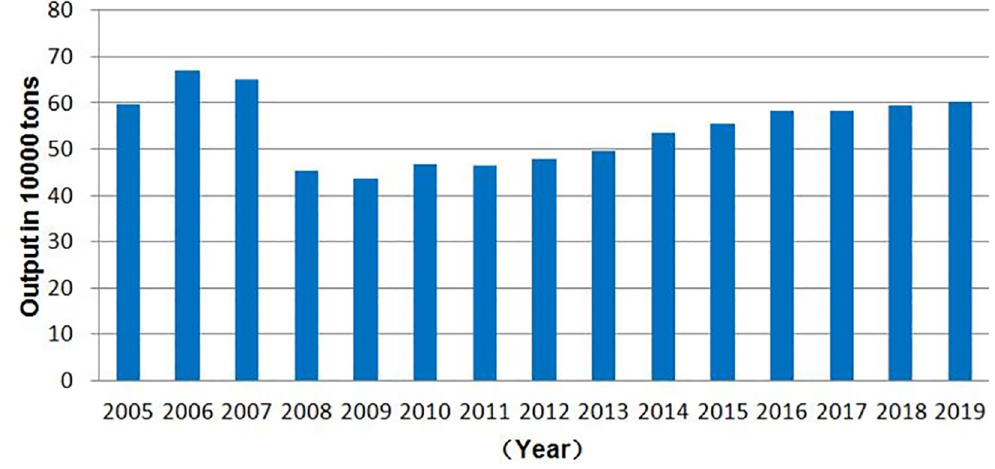
Fig 1. Mutton production in Xinjiang, 2003–2019 (10,000 tons). Note : The data sources are arranged according to Xinjiang Statistical Yearbook